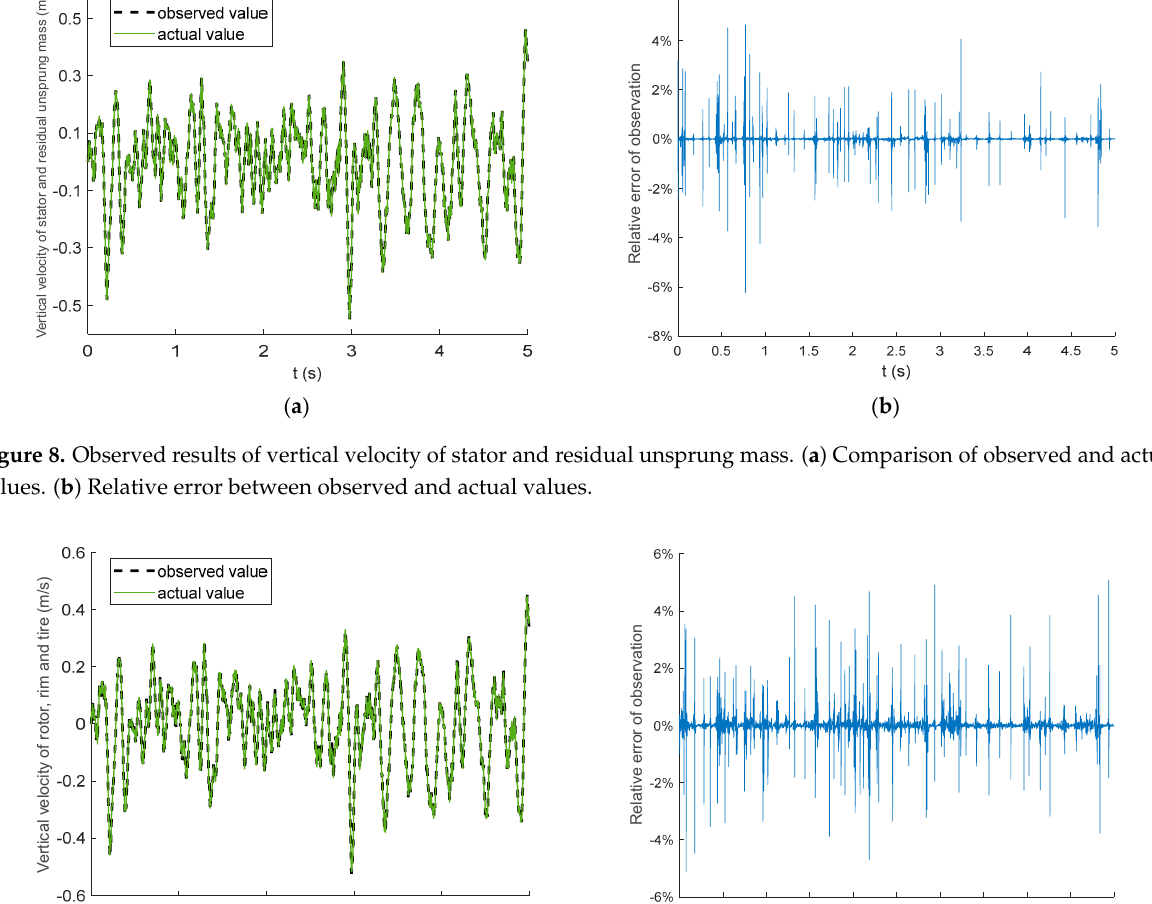
( b ) Figure 10. Observed results of motor stator eccentricity. ( a ) Comparison of observed and actual values. ( b ) Relative error between observed and actual values.